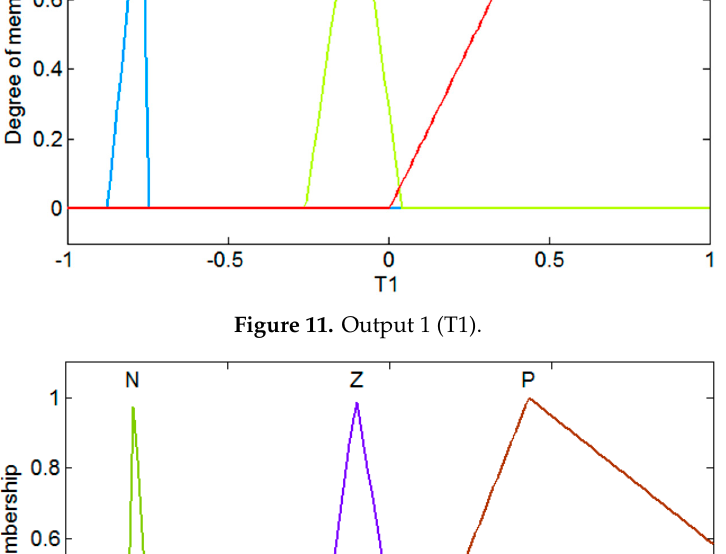
Figure 10. Input 2 (ew).